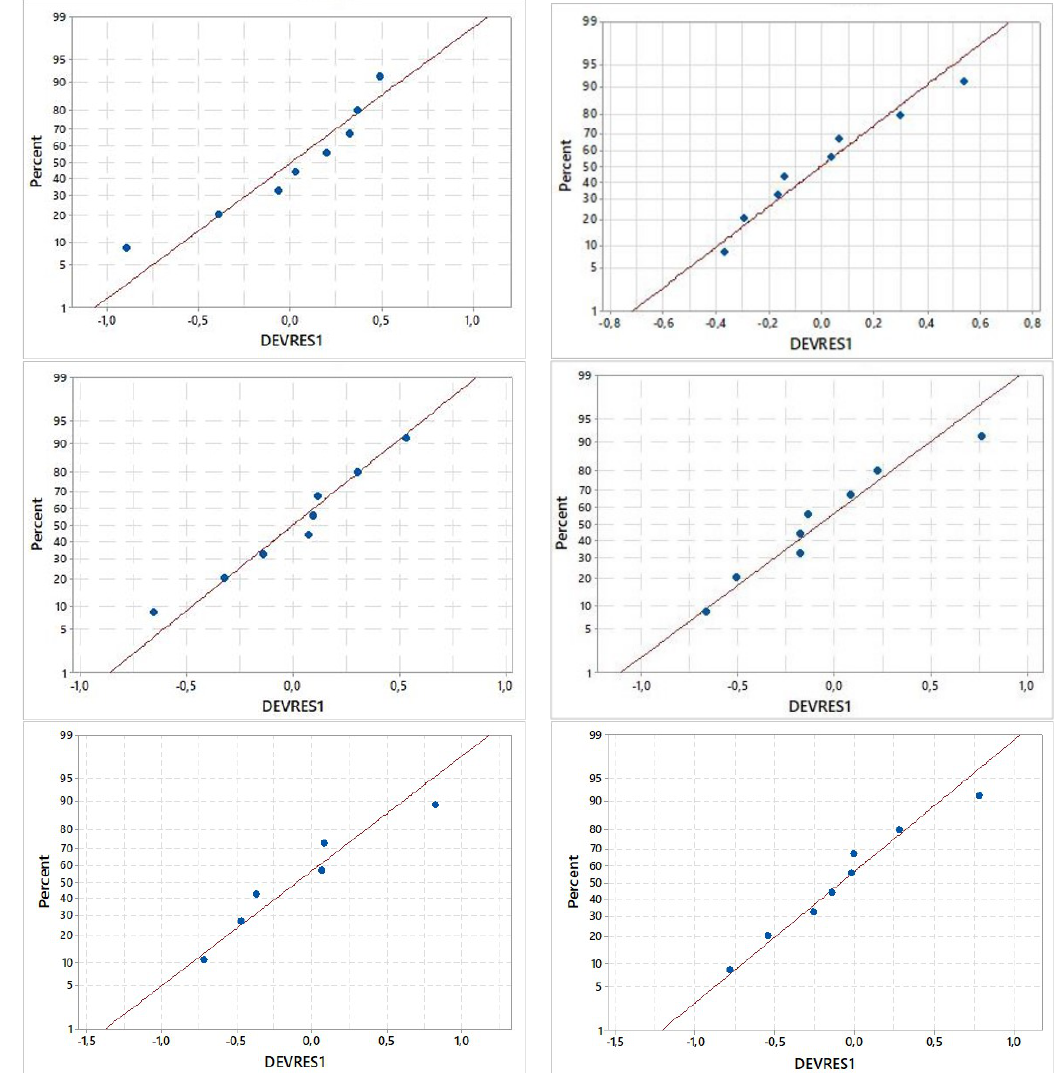
Figure 5. Normality plots of residuals of real SEPA. The sensors are in the first row from the left: Bedroom door (Go to bed) , Bed pressure (Go to bed) , in the second row: Bathroom door (Use the bathroom) , Refrigerator (Prepare breakfast). in third row: Chair pressure (Prepare breakfast) , Chair pressure (Prepare